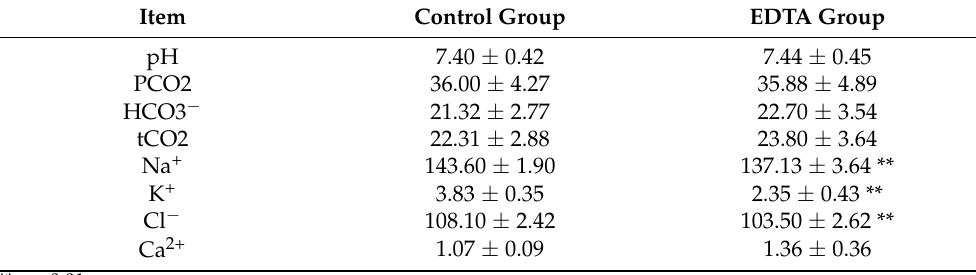
Table 2. Blood gas and electrolyte measurements of sheep in the control and EDTA